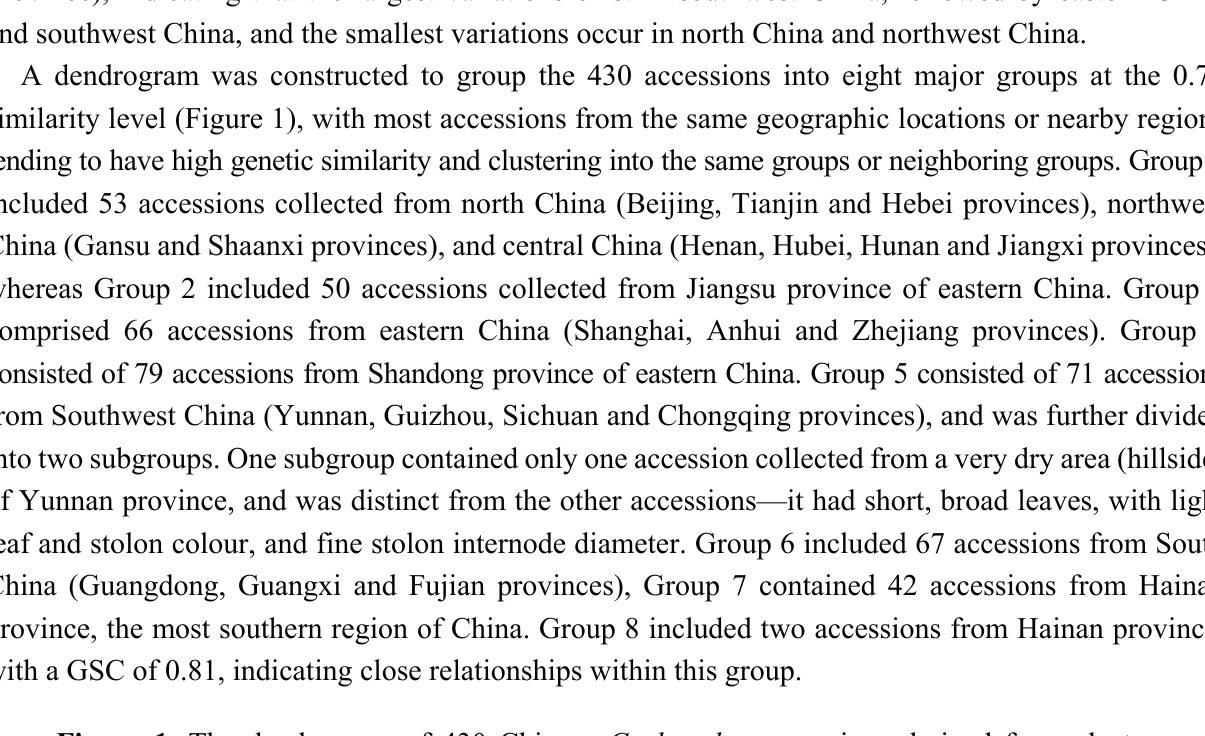
Figure 1. The dendrogram of 430 Chinese C. dactylon accessions derived from cluster analysis (unweighted pair-group method with arithmetic averages (UPGMA)) based on genetic similarity estimates from SRAP marker